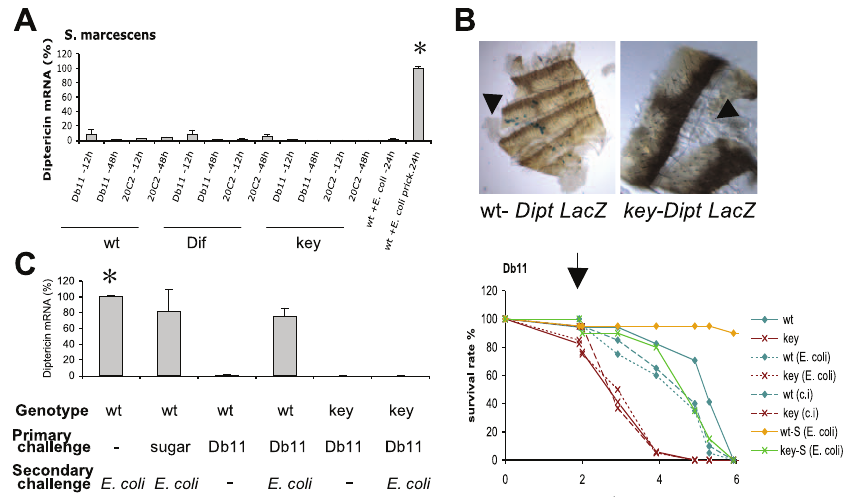
Figure 5. The Systemic Humoral Immune Response Is Not Triggered by Ingested S. marcescens (A) Diptericin mRNA levels were measured by quantitative RT-PCR. No significant expression was induced after feeding with S. marcescens Db11 or 20C2, or with nonpathogenic E. coli 1106 (wt, Dif , key , and wt E. coli samples, respectively). The expression induced by an E. coli 1106 septic injury is taken as a reference (*). No induction of Cecropin expression could be detected; the systemic immune response was not significantly induced at later time points (up to 144 h; unpublished data). (B) No expression of ß-galactosidase was detected in fat body cells of Diptericin - lacZ transgenic flies as indicated by the absence of blue staining in fat body lobules (arrowheads). The expression observed in wild-type flies is in pericardial cells and is also found in key mutants, although they are absent in this dissection. (C) Flies that have fed on Db11 for 48 h (primary challenge) are still able to mount a systemic immune response when pricked by either E. coli (secondary challenge: 6 h after injury) or Db11 (not shown). This response is dependent on the imd pathway as key mutants showed no response. Diptericin mRNA levels were measured by quantitative RT-PCR 54 h after the beginning of bacterial ingestion. *: 100 % reference: wild-type flies challenged with E. coli for 6 h. (D) Flies fed on Db11 are still able to mount an effective immune response since they do not succumb to a secondary E. coli 1106 septic injury (wt and key ( E. coli )) at an enhanced rate, as compared to mock-challenged flies (wt and key (ci); ci: clean injury). The arrow indicates the time point (day 2) at which the secondary challenge was performed (all curves correspond to flies that were feeding on Db11, except for the solid yellow and green lines, which correspond respectively to control wt and key flies fed on sugar [S] solution and challenged with E. coli at day 2). wt and key flies feeding on Db11 and not challenged secondarily by E. coli are also shown (wt and key ).